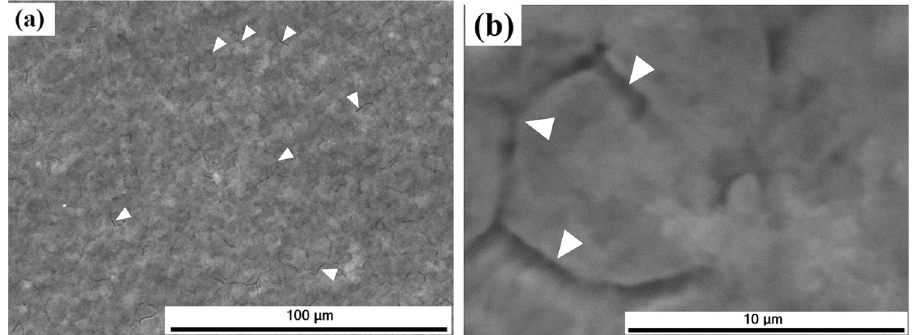
Fig. 10 FTIR spectra of the raw silica NPs solution, the prepared coating solution with addition of 10 wt% PAA (Composition No. 5), and the superhydrophobic coating deposited on the glass slide